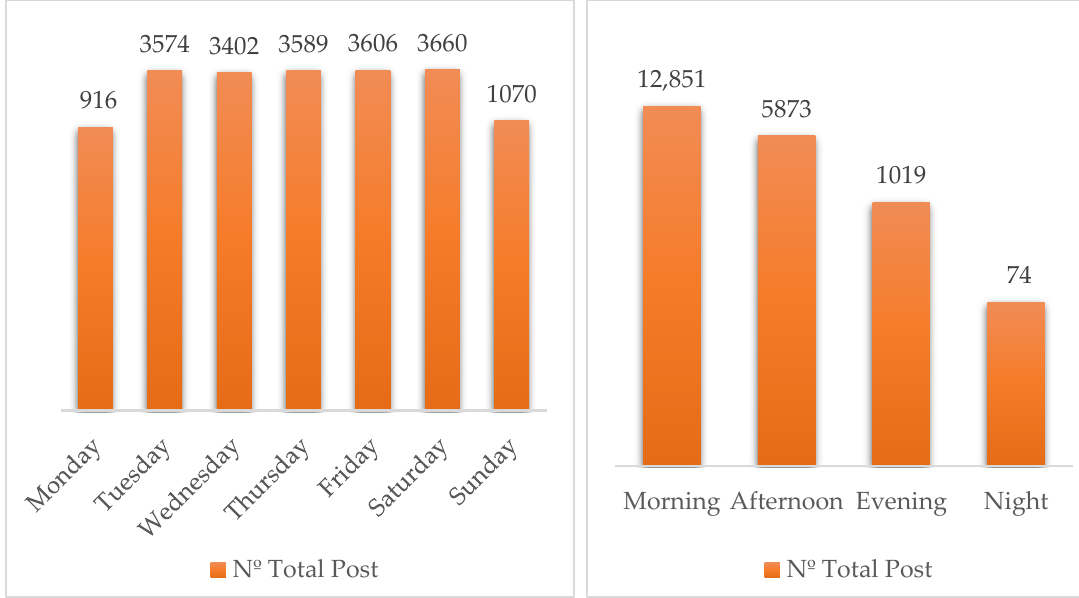
Figure 5. Number of posts per day of the week and per time of the day.